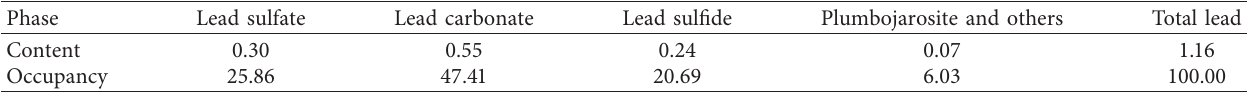
Table 3: Phase analysis results of lead (%).